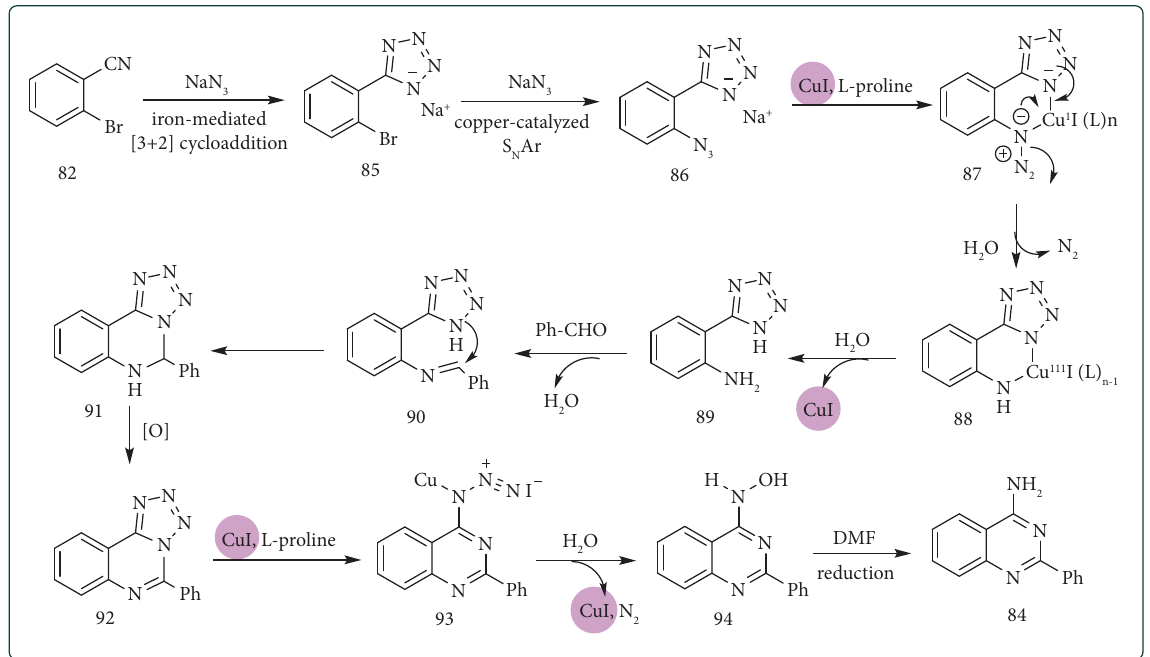
Figure 11: Te proposed mechanism for the synthesis of 2-phenylquinazolin-4-amine derivatives in the presence of FeCl L-proline.